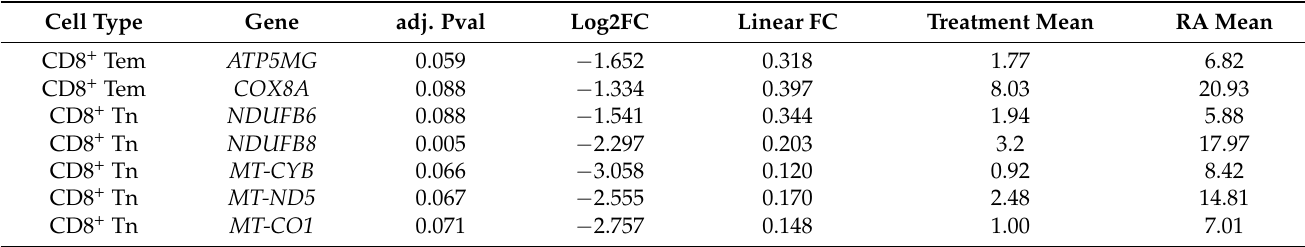
Table 10. Oxidative phosphorylation DEGs in TCZ-treated RA T cell subsets. Means are calculated from DESeq2 normalized